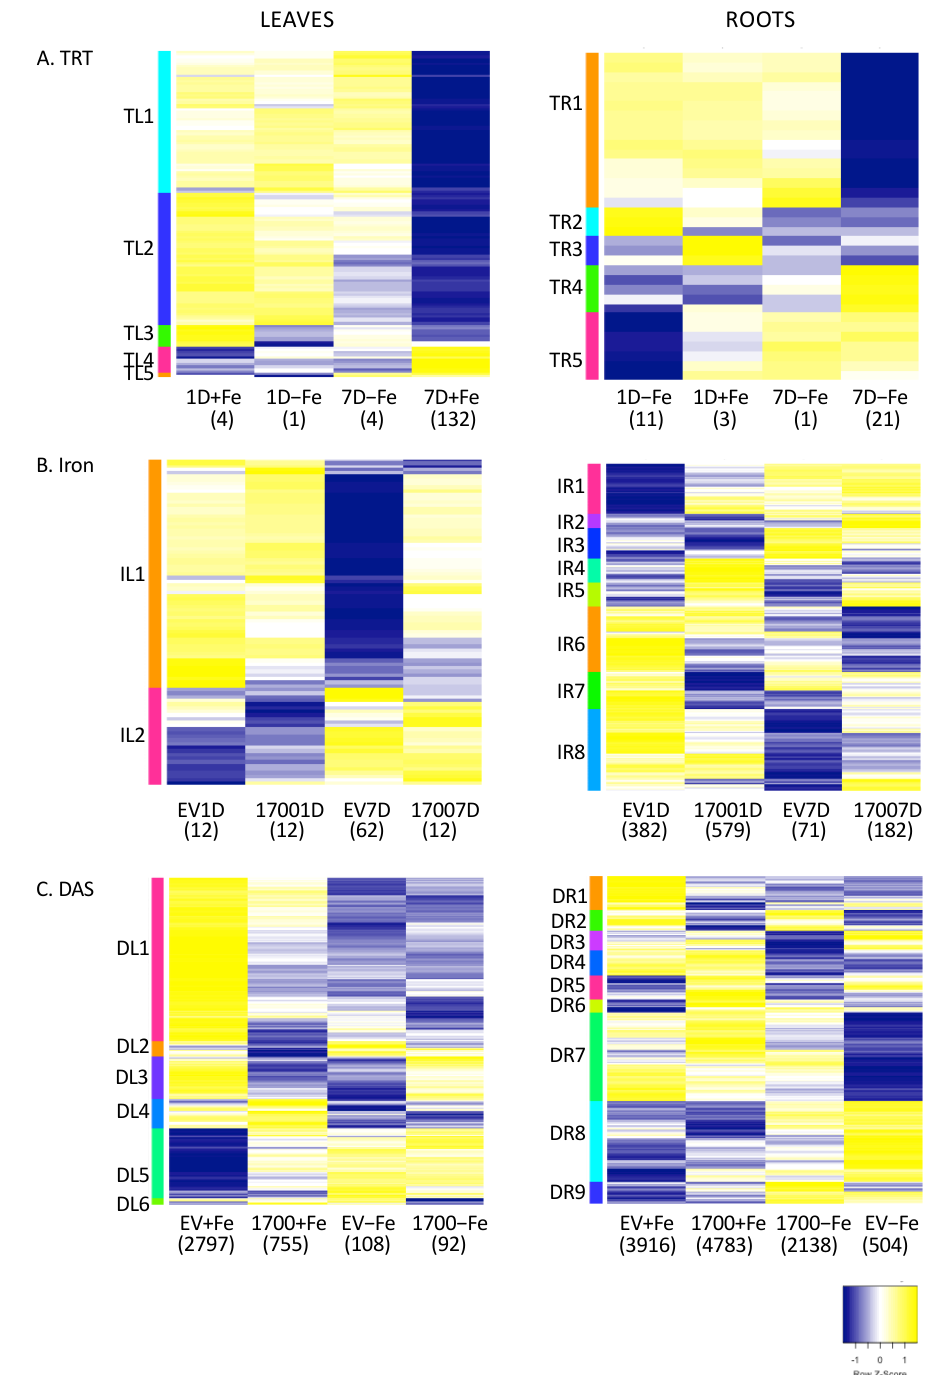
Figure 3. Heatmaps of differentially expressed genes. Z-scores of differentially expressed genes identified from the three analyses ( A ) treatment (VIGS_Glyma.05G001700 vs. VIGS_EV), ( B ) iron status, and ( C ) days of stress (1D vs. 7D). Heatmaps for DEGs identified in leaves are on the left and roots are on the right. Hierarchical clustering was performed in R to identify unique expression clusters, these are denoted to the left of each heatmap by both colored bars and a three-letter code corresponding to either treatment (T), iron status (I) or days of stress (D), tissue (Leaf (L) or Root (R)) and the cluster number. Number of DEGs identified in each comparison is provided in parentheses below the comparison ID. Expression of all DEGs identified in each analysis is represented even if a gene is not statistically differentially expressed in a specific comparison. Negative Z-scores are blue, positive Z-scores are